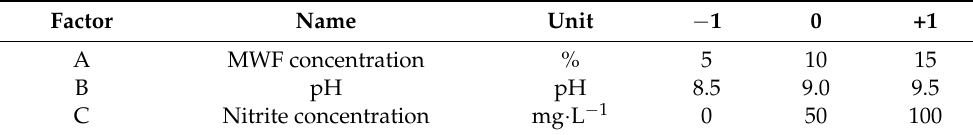
Table 1. Factor levels of the